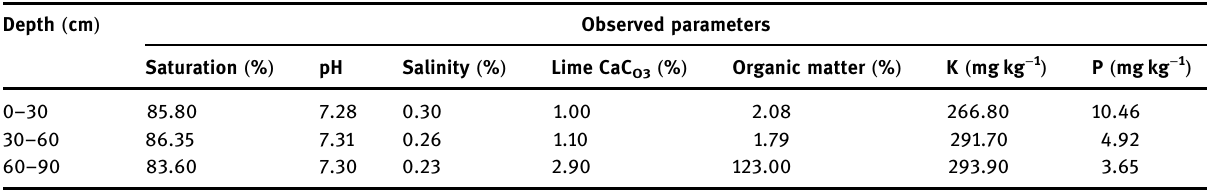
Table 2: Some physical and chemical properties of the experimental soils ( * ) Depth ( cm